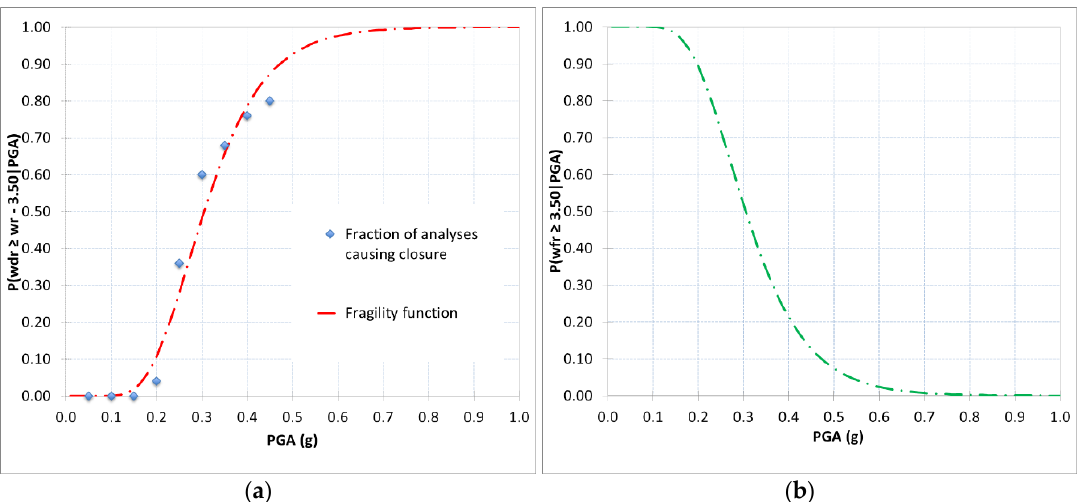
Figure 6. Fragility curve of a generic urban road segment in terms of ( a ) probability of closure and ( b ) probability of